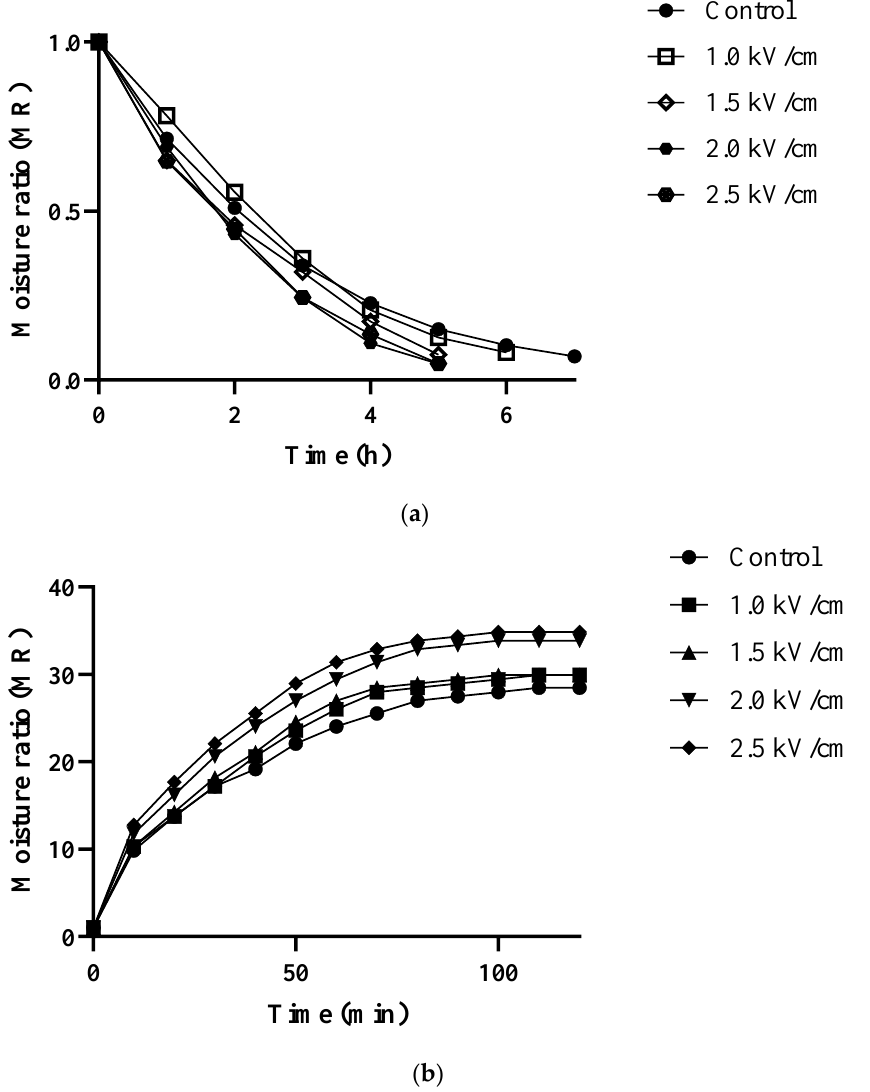
Figure 2. Moisture ratio (MR) of carrot ( a ): drying, ( b ) rehydration with different strengths of PEF pretreatment. Control: untreated; 1.0 kV/cm: carrot treated with PEF 1.0 kV/cm, 1.5 kV/cm: carrot treated with PEF 1.5 kV/cm; 2.0 kV/cm: carrot treated with PEF 2.0 kV/cm; 2.5 kV/cm: carrot with PEF 2.5 kV/cm (n = 3).